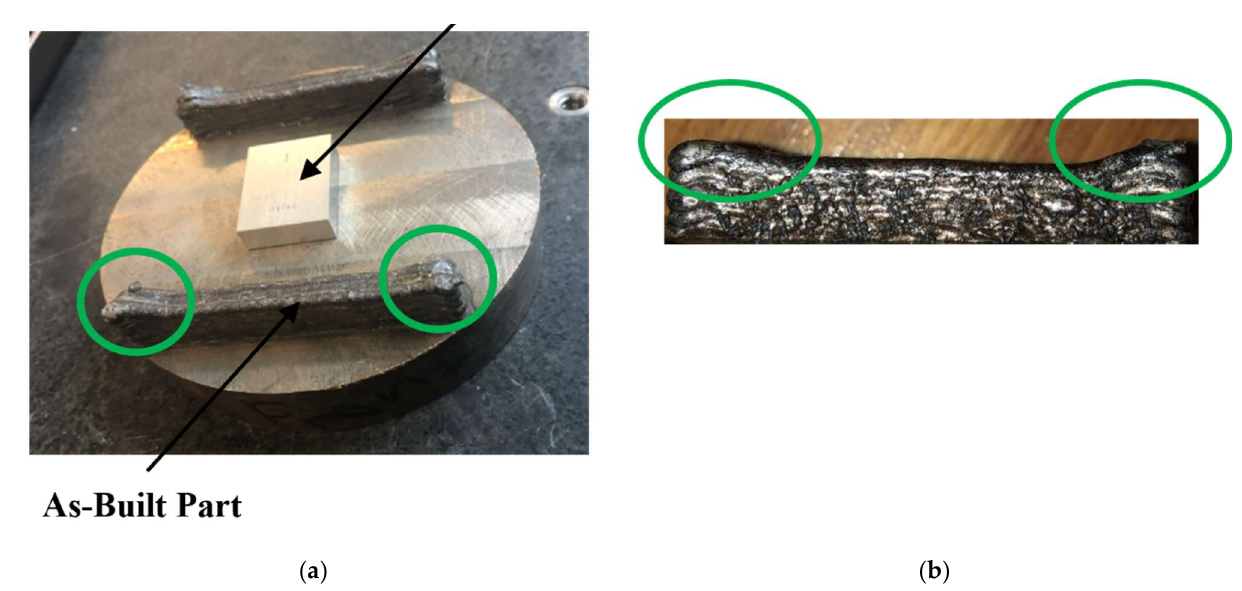
Figure 3. As-built wire directed energy deposition (DED) part: ( a ) on substrate with 1” gauge block for scale; ( b ) side view of part. The green circles indicate the overbuilt regions of the cup geometry.